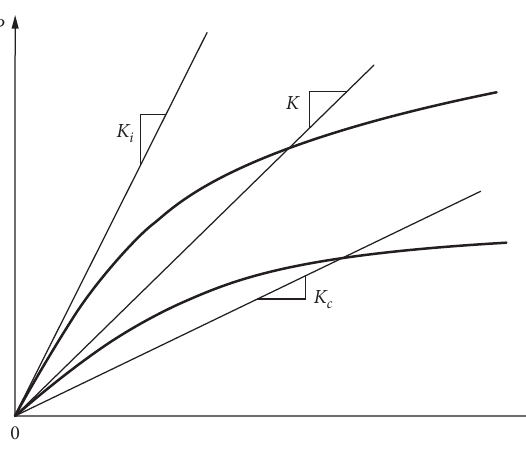
Figure 4: Determination of the disturbance function based on volumetric strain.